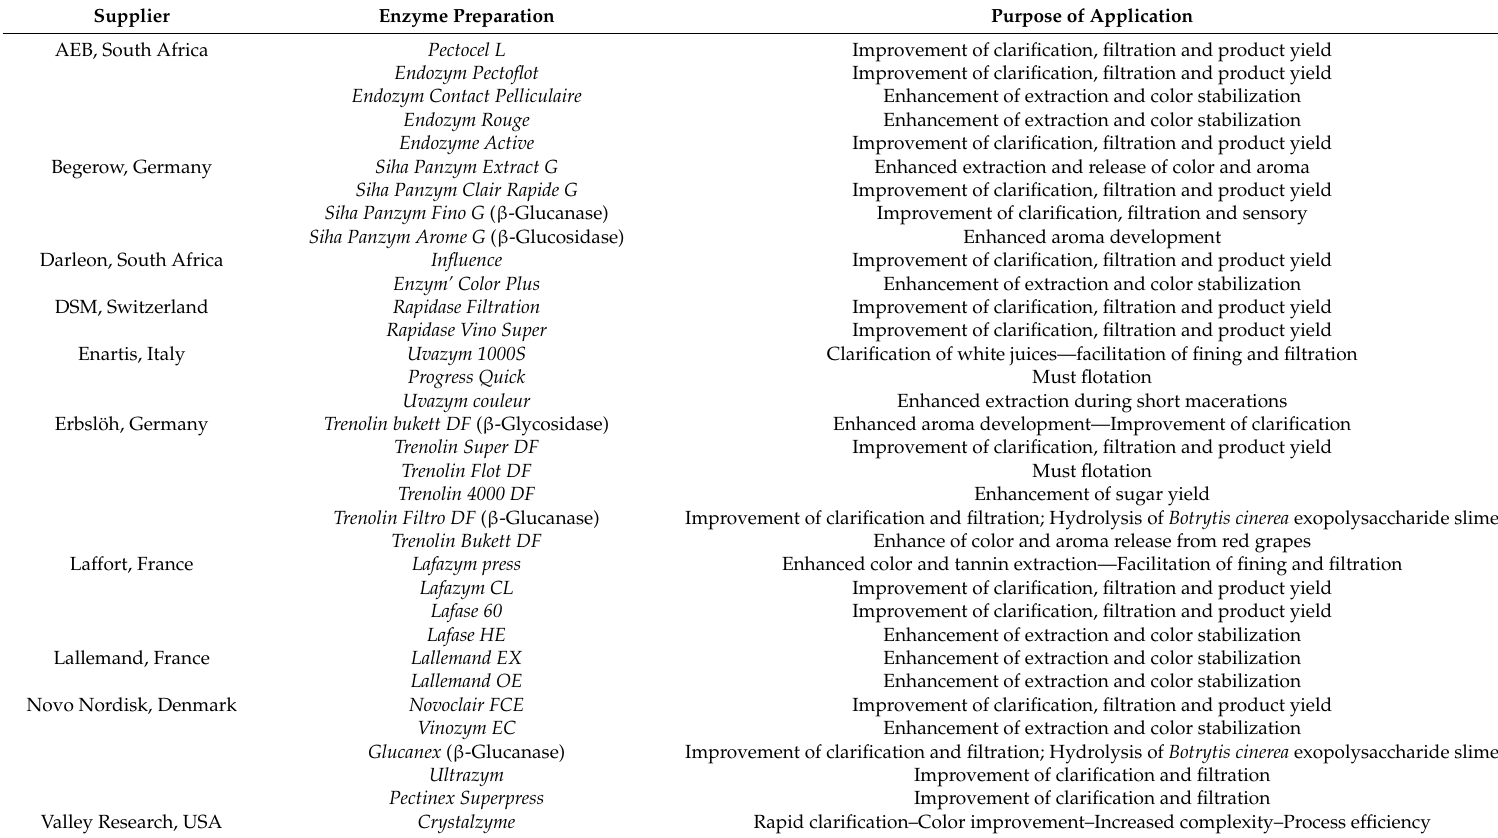
Table 3. Examples of commercial pectinase preparations used for winemaking modified from